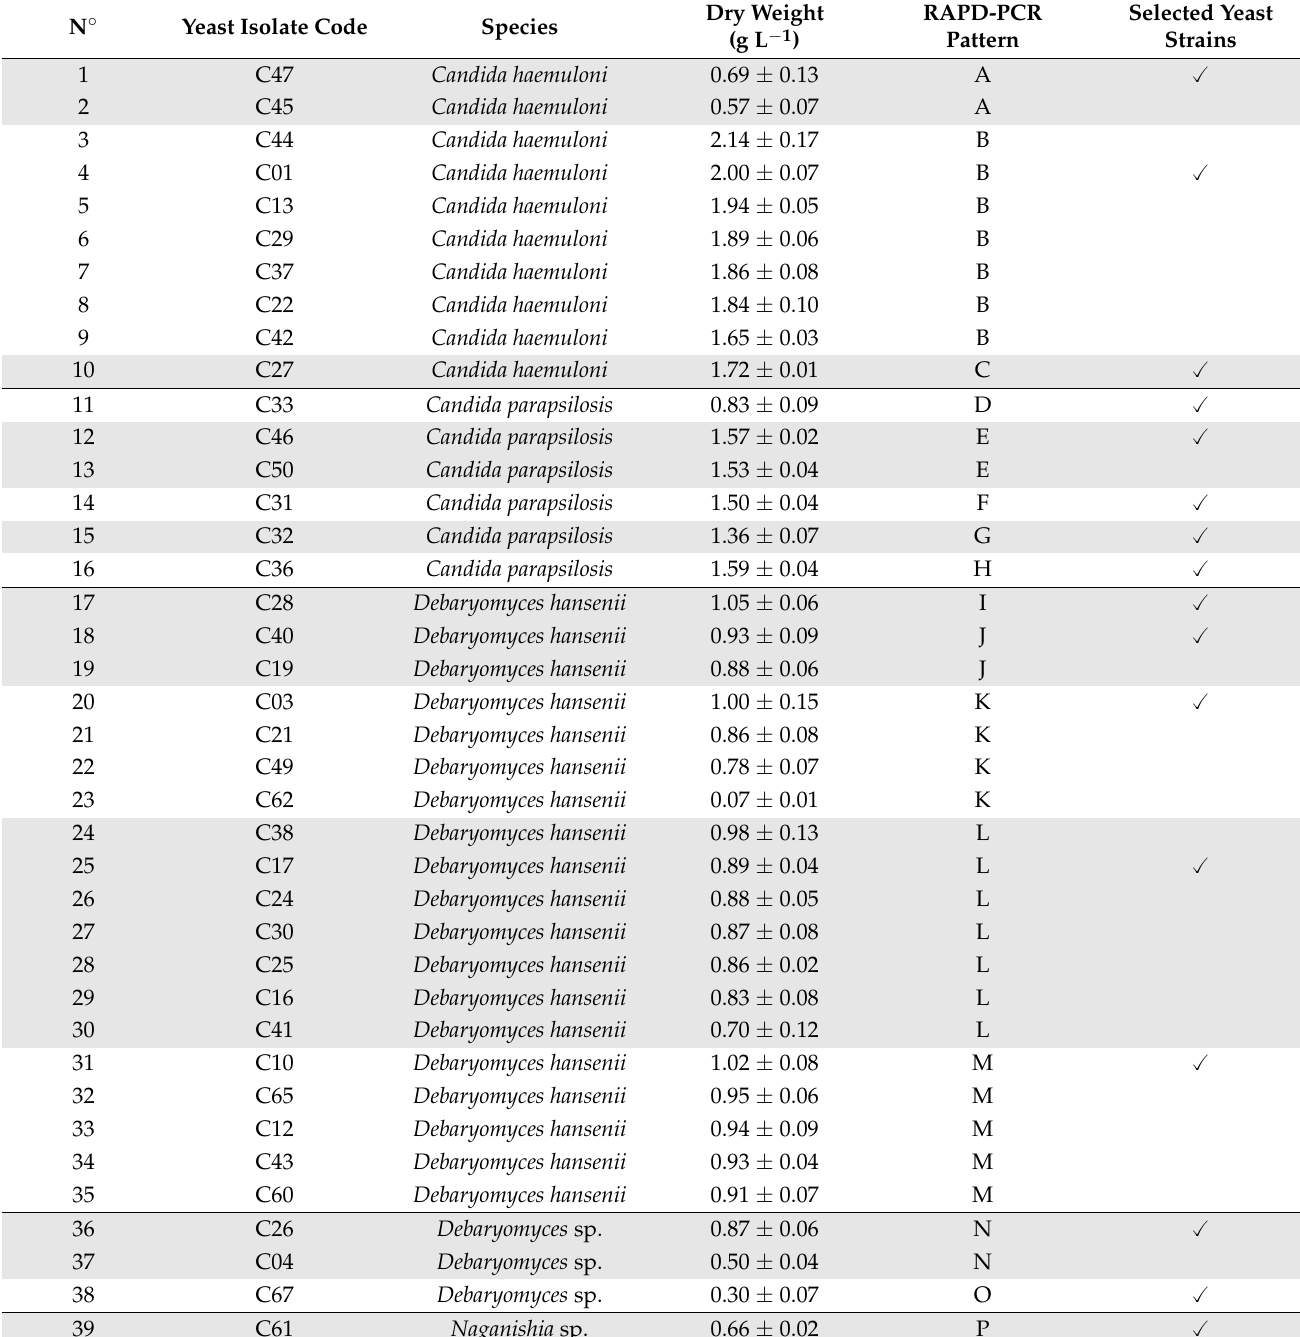
Table 2. RAPD-PCR profiles and biomass production of yeast isolates. Yeasts marked with selected. The results are presented as the mean ± standard